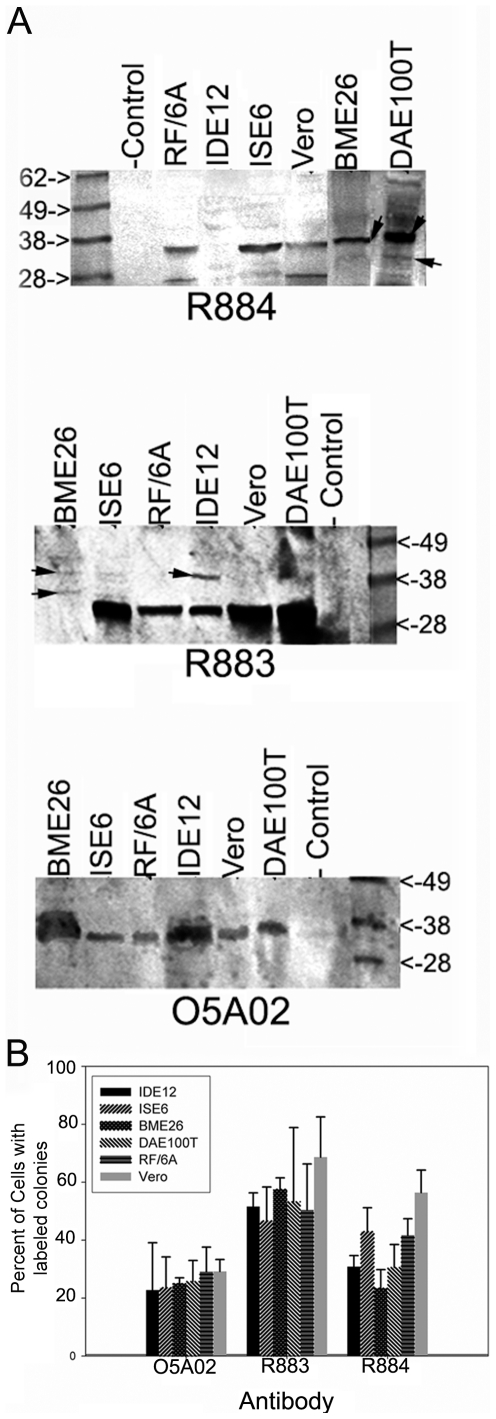
Changes in the expression of Msp2 variants during infection of tick and mammalian cells.(A) Detection of Msp2 variants with monospecific antibodies R884 and R883 and monoclonal antibody O5A02 by Western blots. Controls consisted of uninfected ISE6 and IDE12 cell protein extracts. (B) Variation in recognition between Msp2 specific antibodies using immuno fluorescence assays. Bars length represent the percentage of A. marginale VA colonies recognized by a monoclonal antibody or monospecific antibodies in a specific cell line. Error bars indicate the standard deviation.